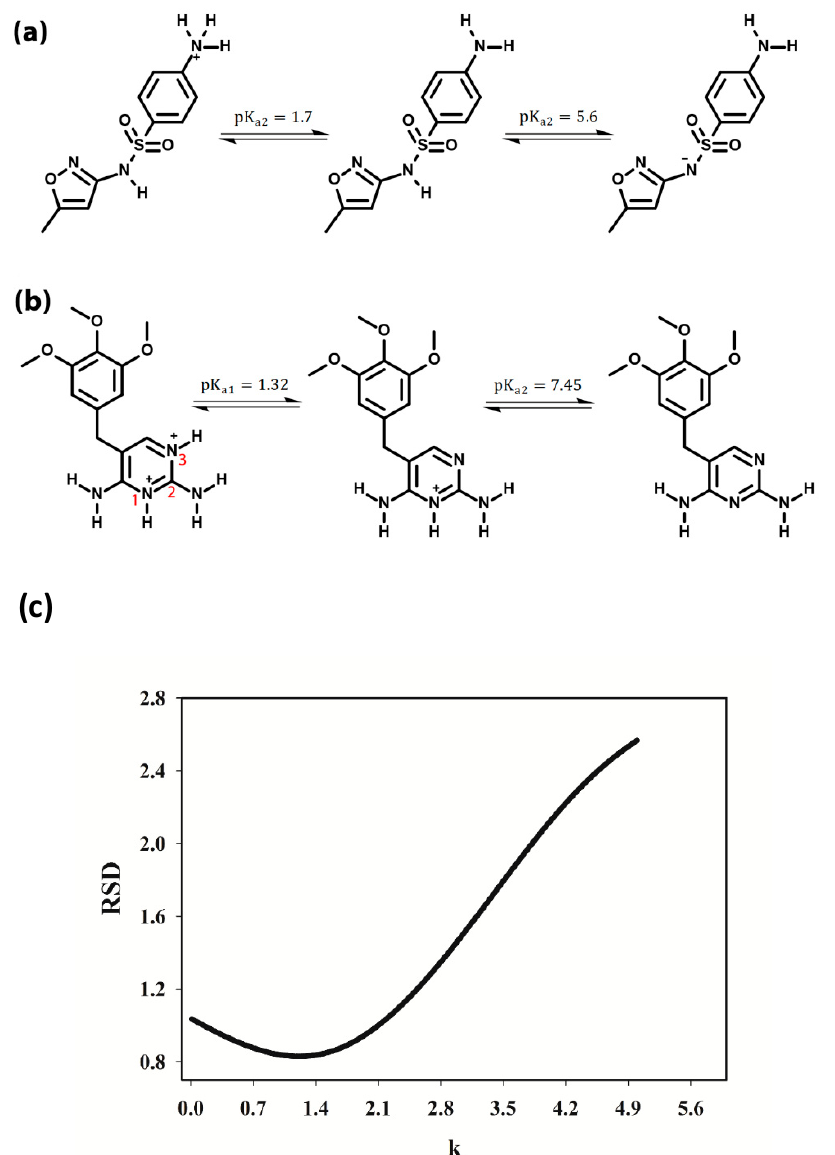
Figure 5. The structures of sulfamethoxazole ( a ) and trimethoprim ( b ) at different pH values; and ( c ) RSD values obtained for parameter k values in RAFA analysis.